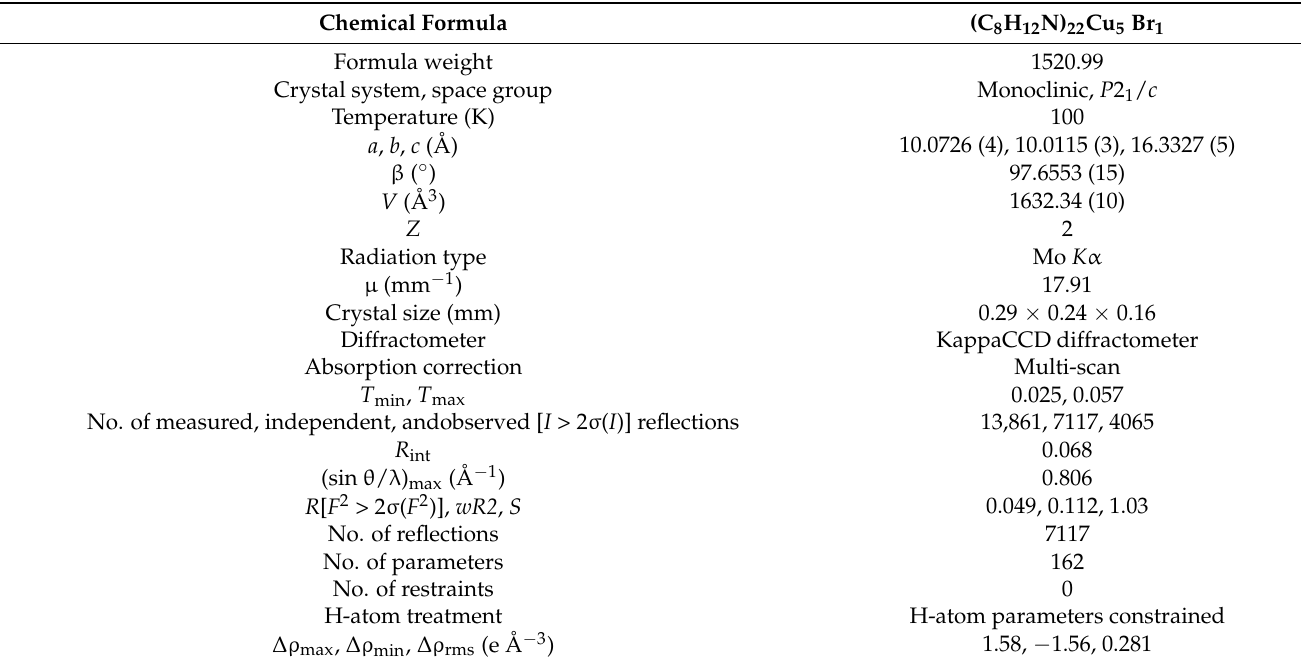
Table 1. Experimental details.